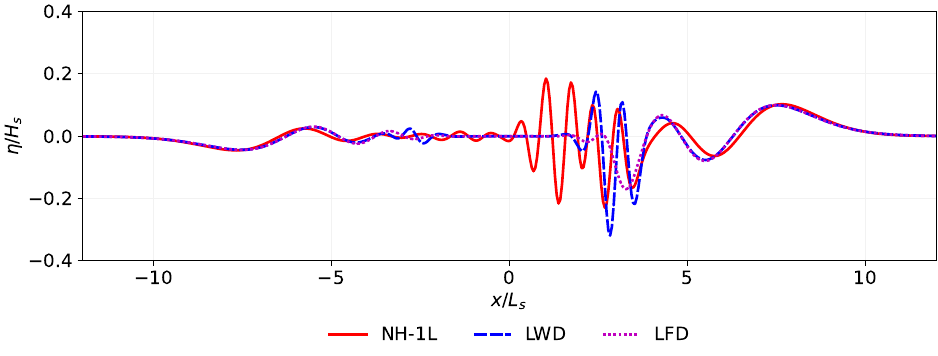
(cid:112) g / L s = 12 resulting from the NH-1L simulation are Figure 8. Free surface profiles at time t compared with the LWD and LFD models for the dispersion parameter µ = 0.5.